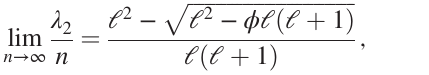
ffiffiffiffiffiffiffiffiffiffiffiffiffiffiffiffiffiffiffiffiffiffiffiffiffiffiffiffiffiffiffi p l 2 − ϕ l ð l þ 1 Þ